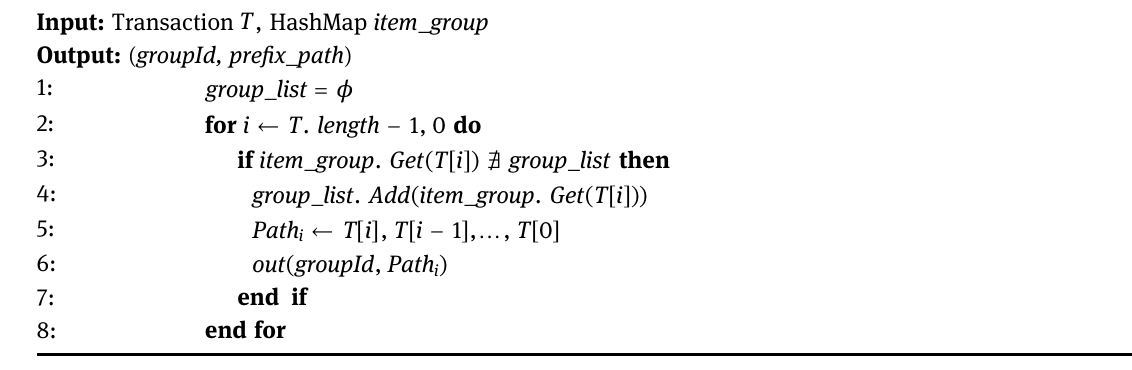
Algorithm 2 Algorithm for the generation of local CPB by transaction partitioning